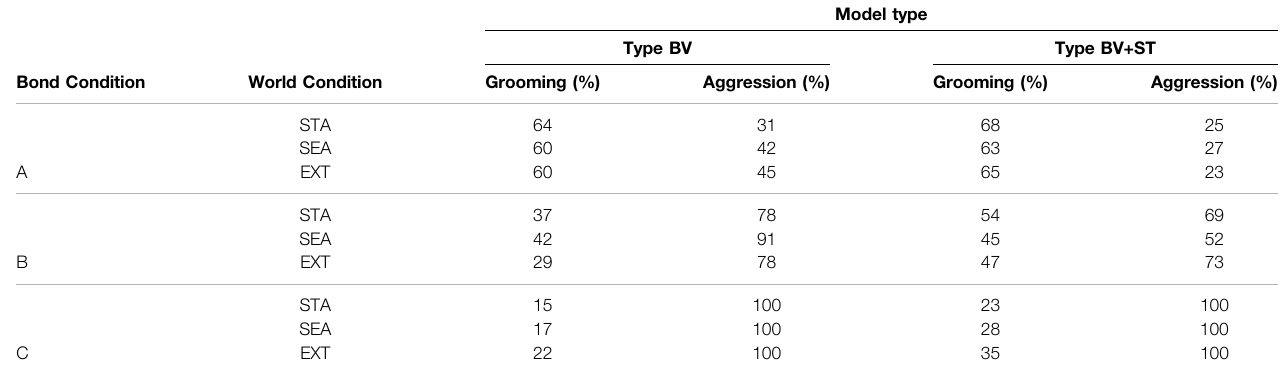
TABLE6| Ratesofintra-bond Grooming and Aggression ,determinedasapercentageofoverall Grooming and Aggression behavioursperformedbybondedagentsineach condition. STA, Static, SEA, Seasonal, EXT, Extreme world